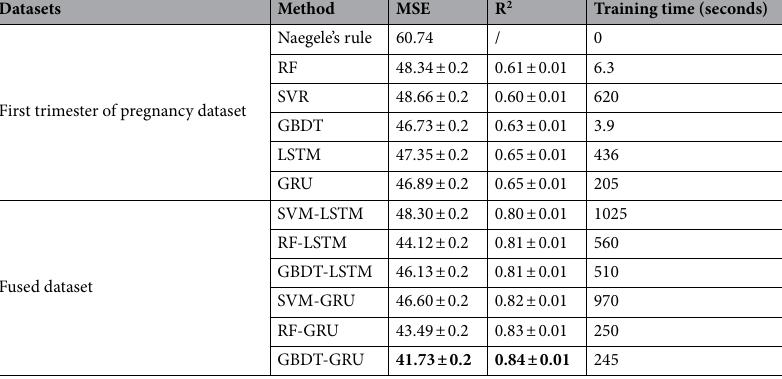
Table 4. Performance of different methods compared in two